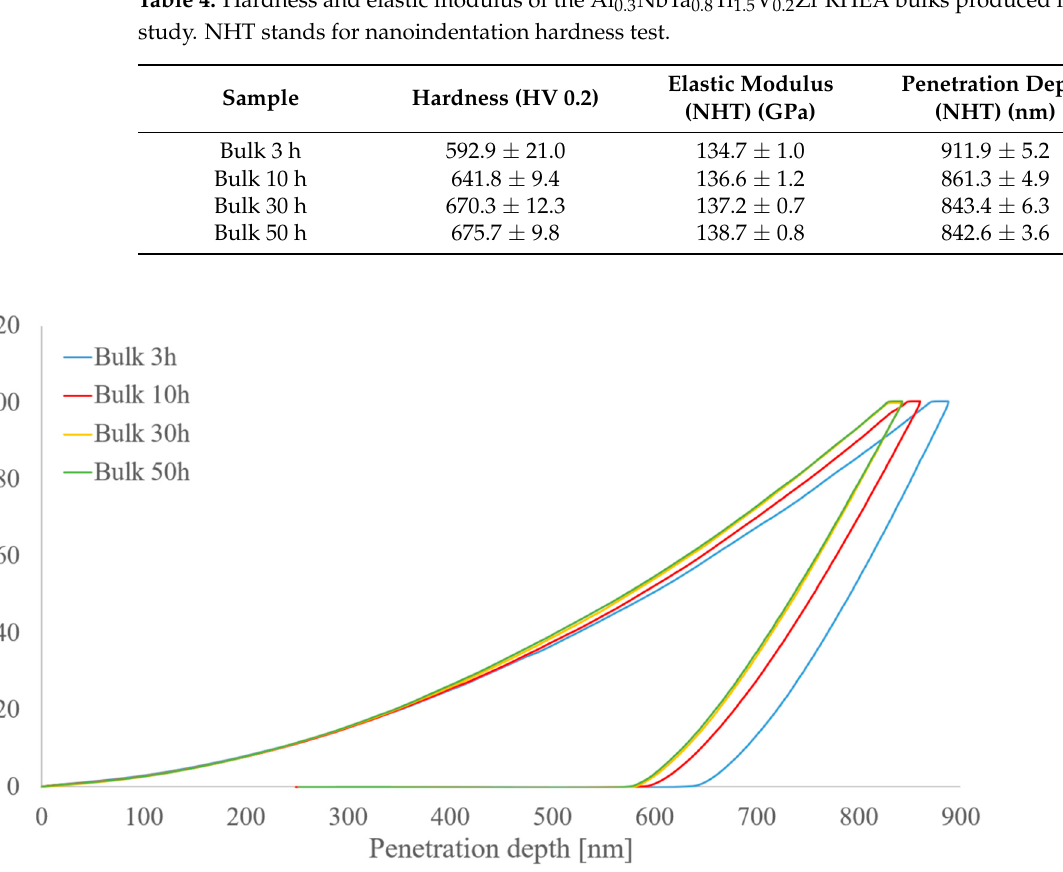
Figure 9. Representative plots of applied force vs. penetration depth from the nanoindentation hardness test of the Al 0.3 NbTa 0.8 Ti 1.5 V 0.2 Zr RHEA bulks. The bulk produced with mechanically alloyed powder for 3 h has the highest values of penetration depth in comparison with the others.